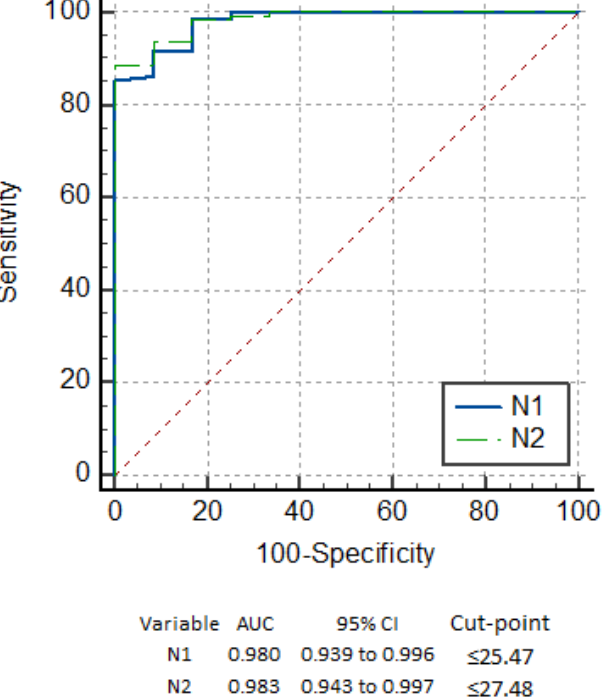
Figure 1. ROC curve for COVID-19 Ag RDT at cut-point where maximum sensitivity and specificity achieved for N1 and N2 targets.